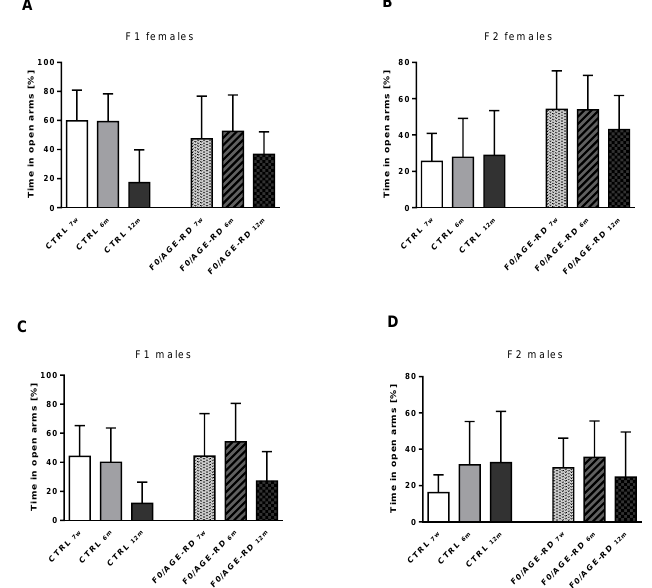
Figure 4. Time spent in open arms in the elevated plus maze test. F1 females ( A ), F2 females ( B ), F1 males ( C ), F2 males ( D ). GLM (3 × 2 × 2 = age, F0 diet, generation: Females: F (2, 221) = 20.5, p < 0.001; males: F (2, 96) = 8.5, p < 0.001). F0 diet, no significant impact in either sex. Values are presented as mean + standard deviation (CTRL = groups fed with control chow, F0/AGE-RD group = F1 and F2 offspring of F0 dams fed with AGE-rich diet, 7w = 7 weeks of age, 6m = 6 months of age, 12m = 12 months of age).